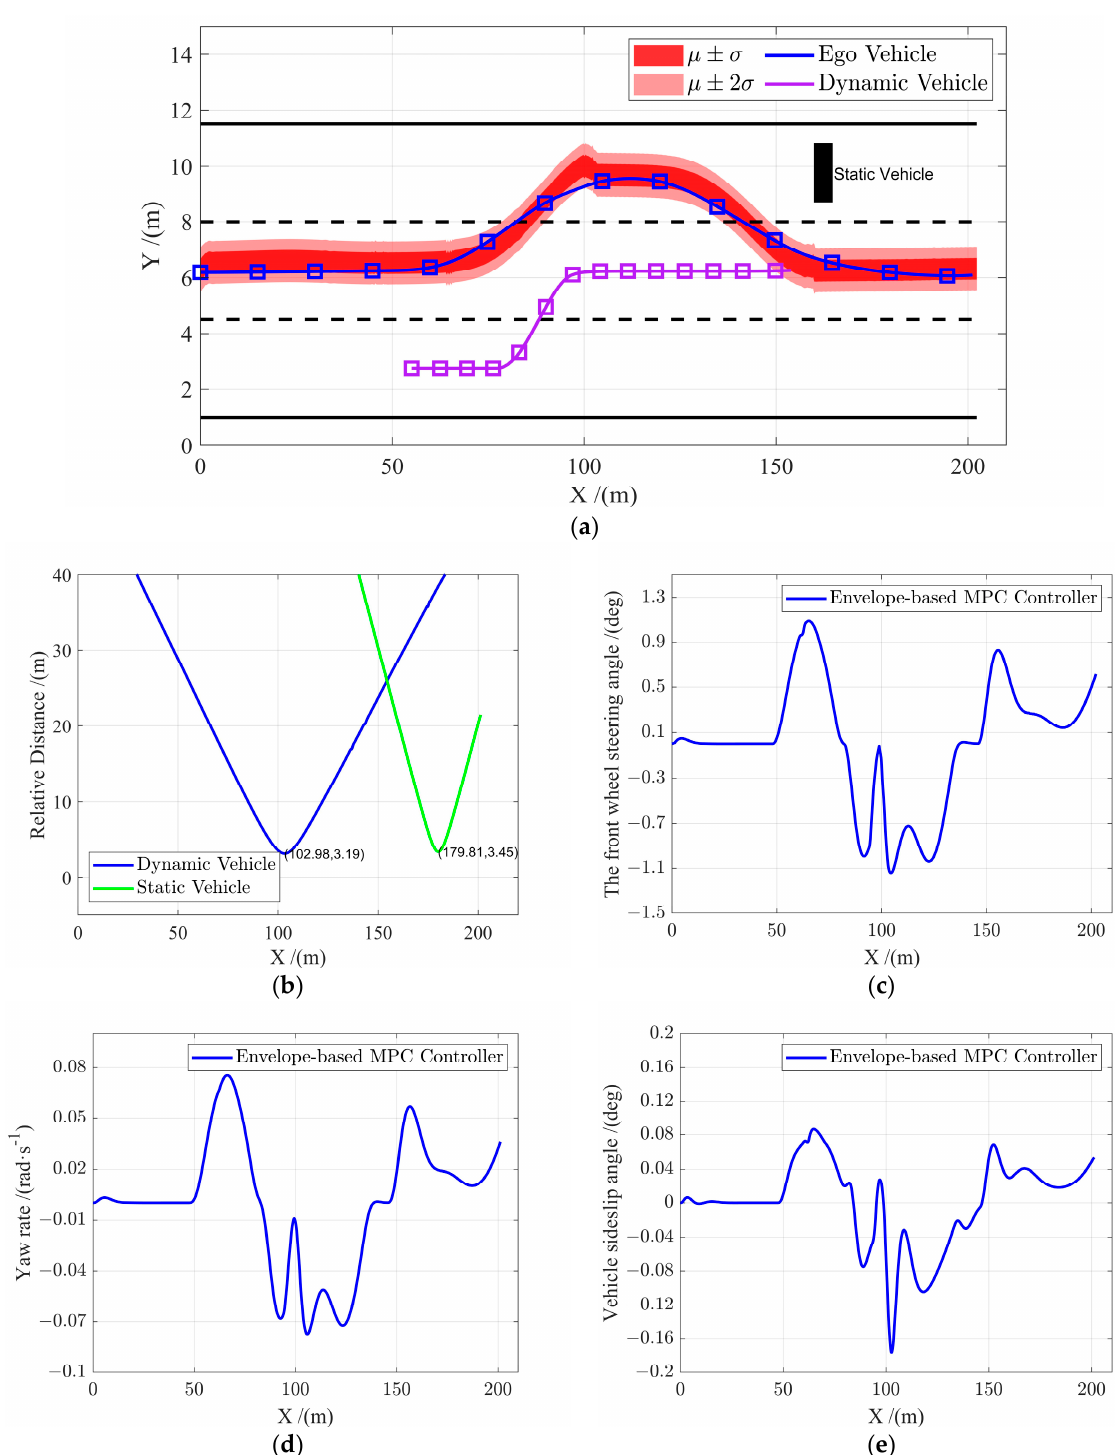
Figure 10. Obstacle avoidance experiment results of scenario C. ( a ) GPR − based obstacle avoidance envelope and vehicle obstacle avoidance trajectory. ( b ) Relative distance. ( c ) The front wheel steering angle. ( d ) Yaw rate ( e ) Vehicle sideslip angle.